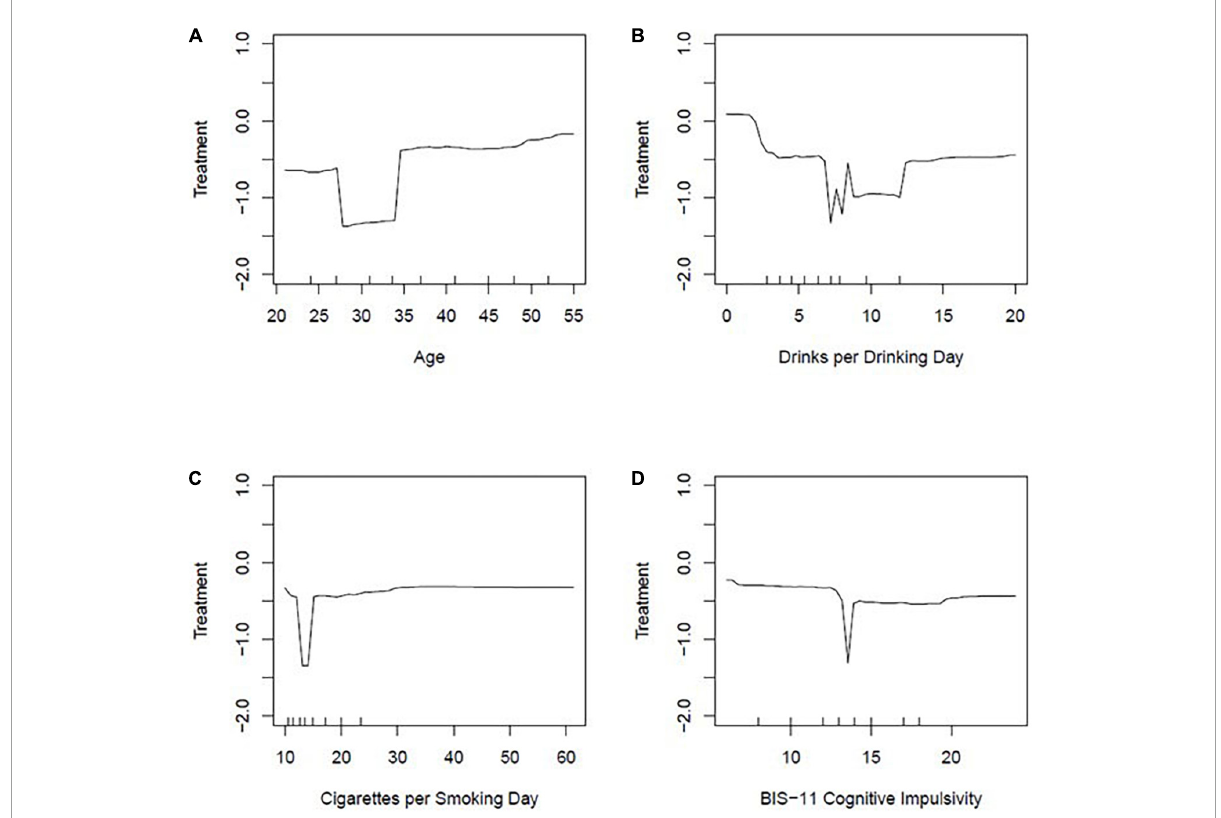
FIGURE2 Partial dependence plots: (A) Age, (B) drinks per drinking day, (C) cigarettes per smoking day, (D) BIS-11 cognitive impulsivity. Partial dependent plots are displayed to show the effect of 4 variables (age, drinks per drinking day, cigarettes per smoking day, BIS-11 cognitive impulsivity) on the log-odds of treatment seeking